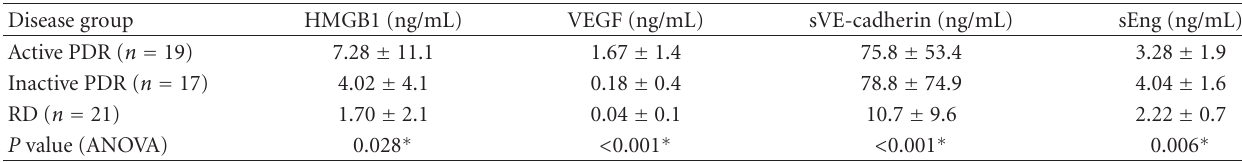
Table 2: Comparisons of mean angiogenesis biomarker levels in proliferative diabetic retinopathy (PDR) patients with or without active